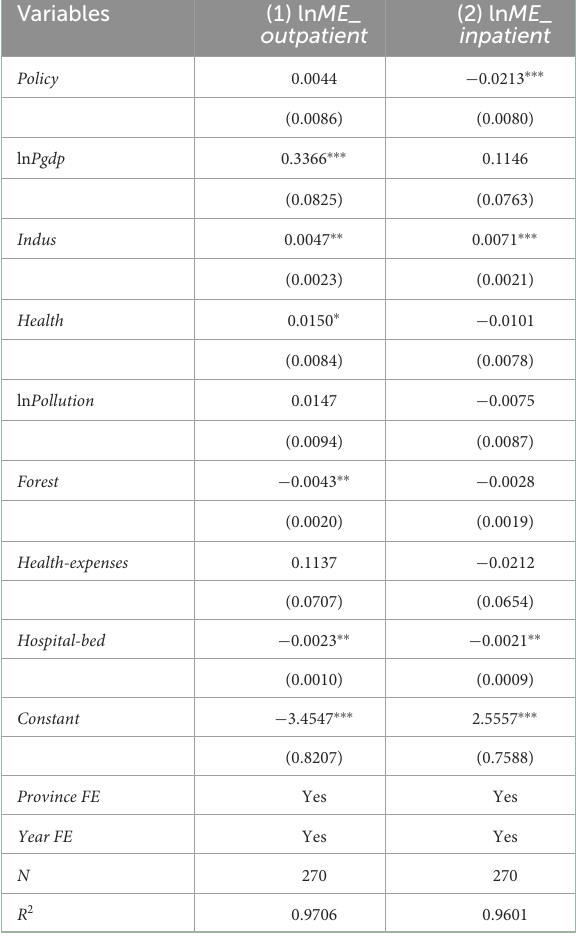
TABLE 3 Benchmark regression